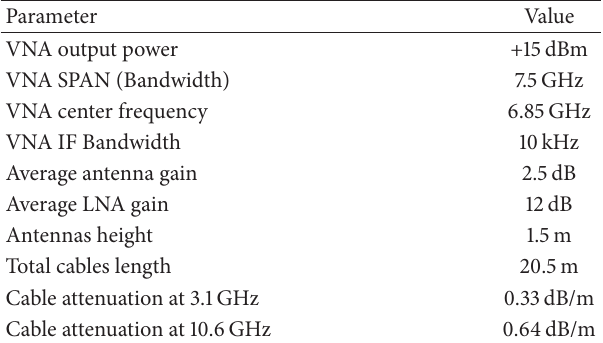
Figure 1: Top view of the propagation environment and Tx/Rx locations. Table 1: Measurement system